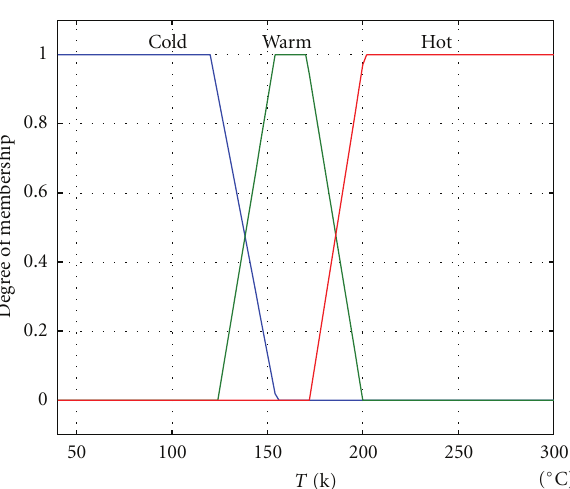
Figure 4: Membership function of the inside